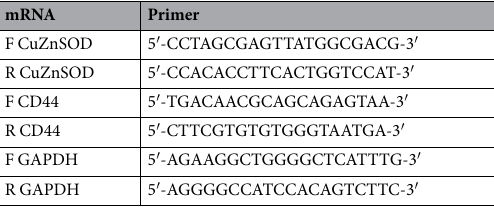
Table 2. Sequences of